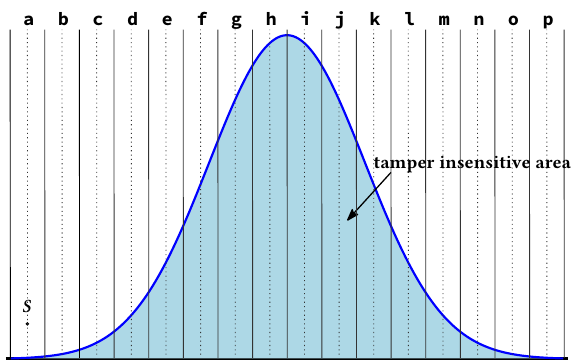
Figure 4: TS max of Profile 2. Based on a single value X of a node, it is not possible node to detect tampering, since any magnitude changes result in d Hamming distance is defined for strings of higher-order